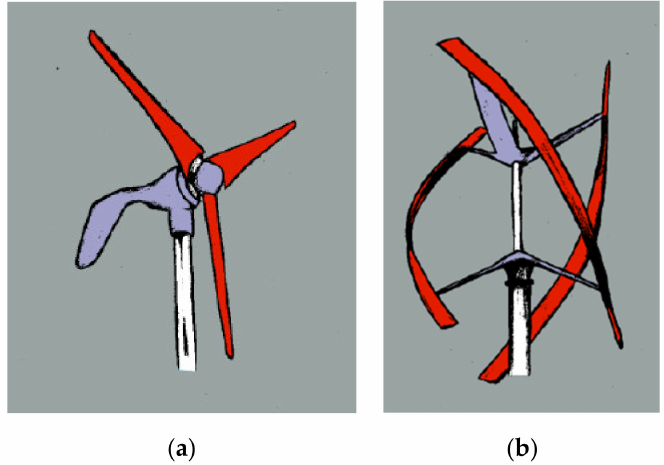
Figure 1. Wind turbines using lift force; ( a ) HAWT; ( b ) VAWT.